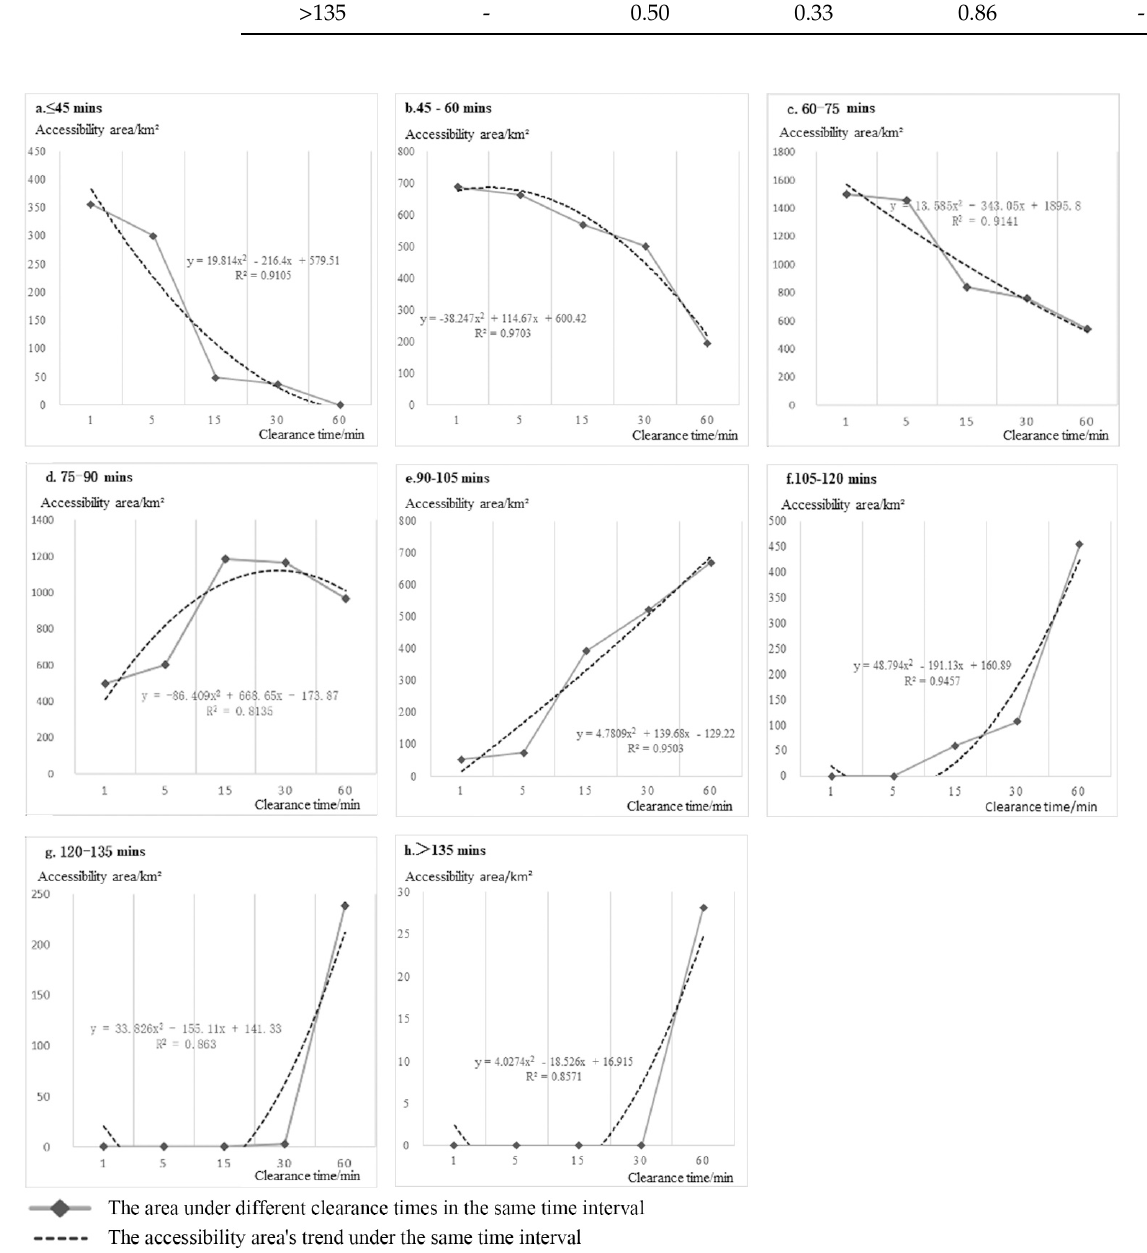
Figure 5. Changes in the accessible area for different clearance times in different time